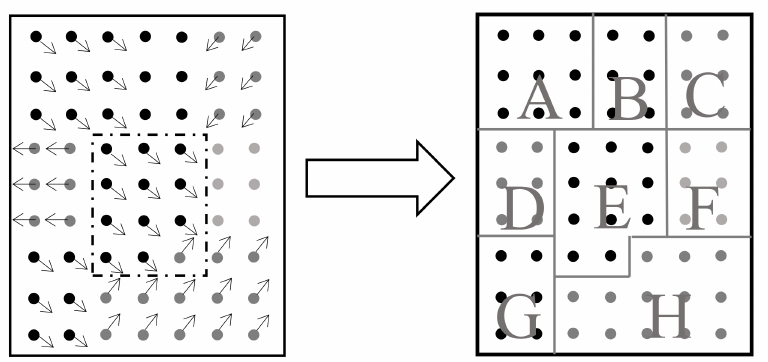
Figure 6. Context and division